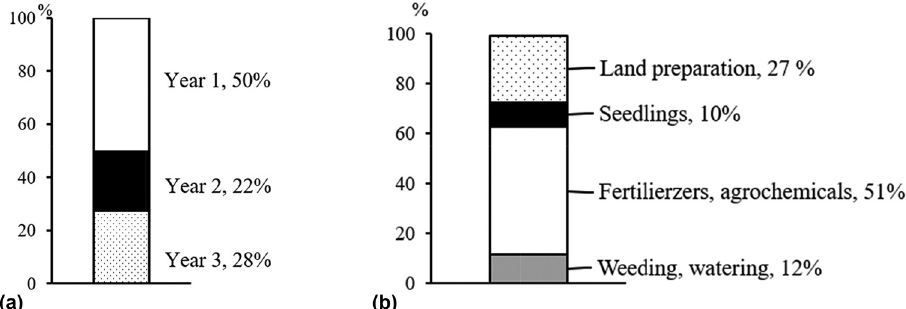
Figure 2: Cost structure of distributed fi xed costs of Idor longan growers in 2019 in the Mekong Delta, Vietnam: ( a ) by year investment and ( b ) by main cost